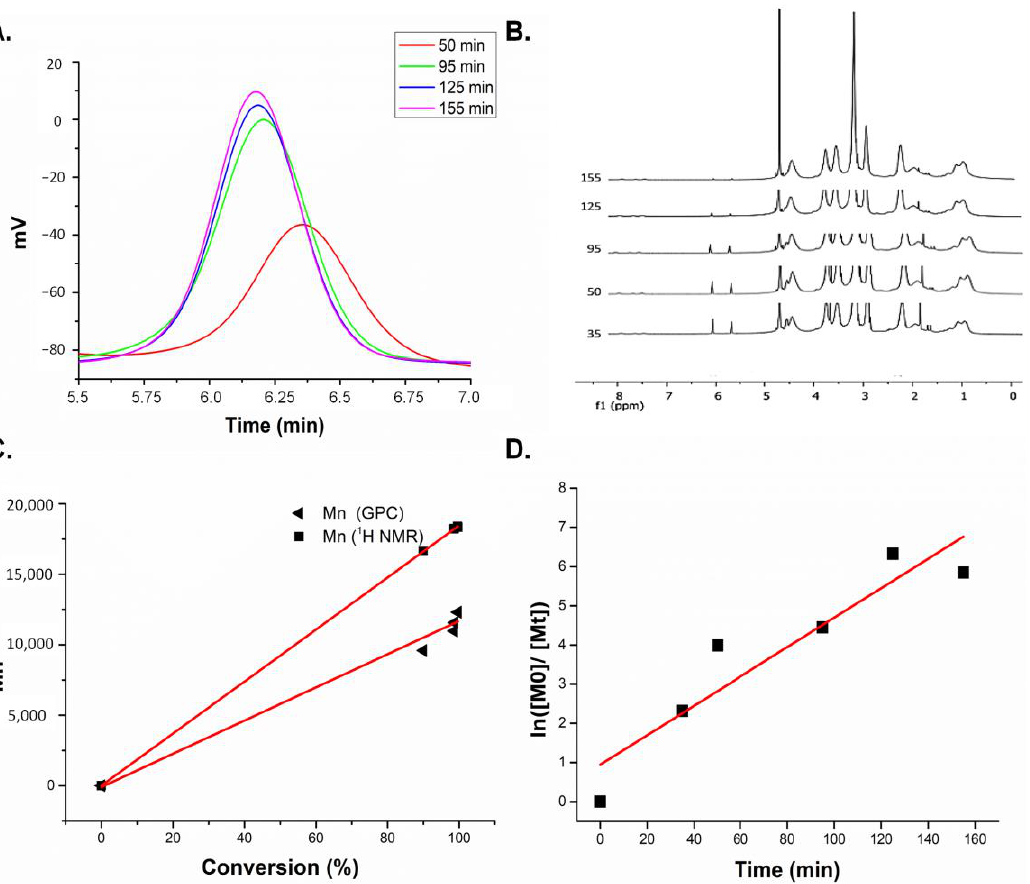
Figure 1. Evolution of GPC chromatograms of sulfobetaine at different times of RAFT polymerization acquired from LS detector (concentrations of all samples were identical in GPC analyses). ( A ) 1 H NMR spectrum of sulfobetaine at different times. ( B ) Relationship between molecular weight and monomer conversion of sulfobetaine polymerizations. ( C ) Kinetics of RAFT polymerization of sulfobetaine ( D ).